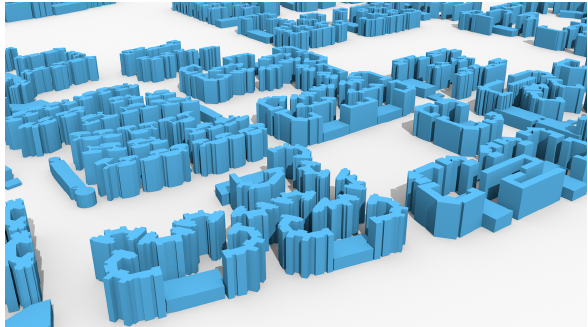
Figure 9. A semantic LoD1 building model of residential build- ings in Singapore generated in the frame of this research, con- flating OpenStreetMap data and an open dataset released by a Singapore Government agency. The resulting data (CityJSON) and the code are released